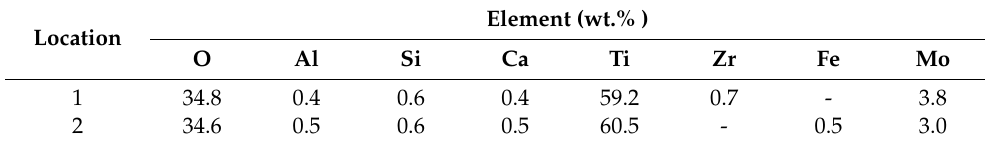
Table 14. Elemental analysis from locations in Figure 16.